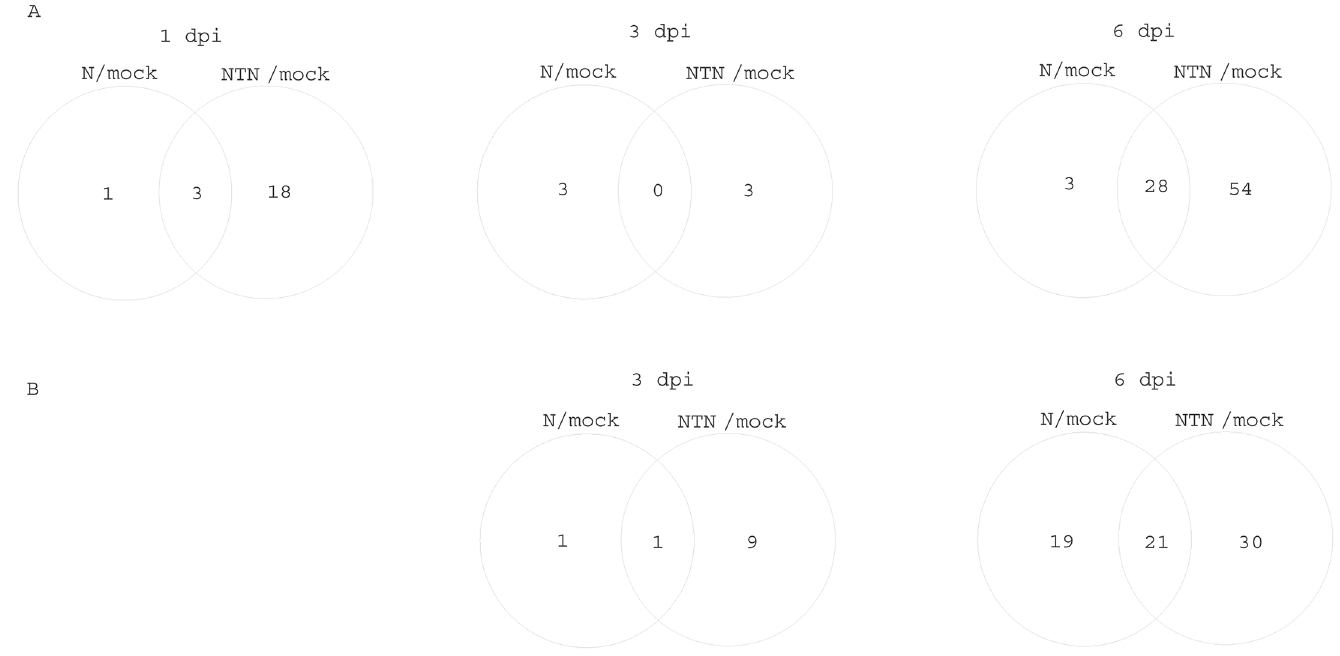
Fig 2. Venn diagrams showing the numbers of statistically significantly differentially accumulated metabolites at the different times in the inoculated leaves (A) and non-inoculated leaves (B). Diagrams are showing the number of metabolites in PVY N -inoculated and PVY NTN -inoculated leaves, relative to the mock-inoculated leaves (N/mock, NTN/mock, respectively). The intercept areas show the numbers of metabolites that were common to both of the plant responses in the